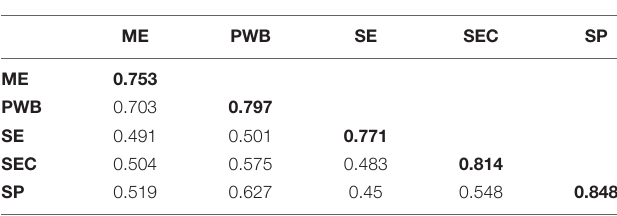
TABLE 3 | Fornell and